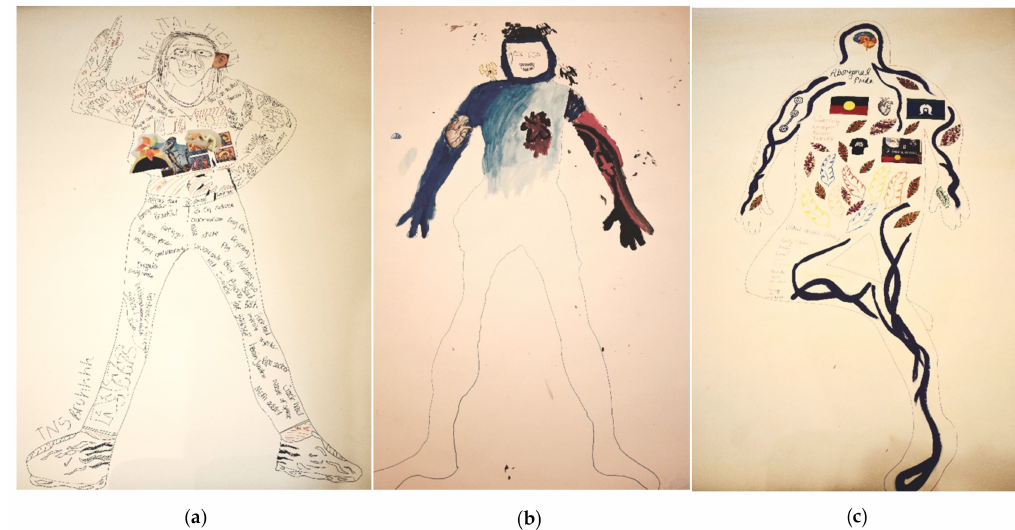
Figure 3. Examples of Body Maps: ( a ) Emma’s Body Map—Emma described how when she initially started her Body Map, she was in a very negative mindset, so she wrote negative words and illustrated her previous drug use on the right side of her body. However, through the Body Mapping process, she was able to start thinking more positively and was able to include more positive words and the family members and friends who have supported her on the other side of her Body Map. ( b ) Liam’s Body Map—Liam expressed how the blue colour included in his Body Map represented his love for swimming, which is an activity he used to enjoy with his family and is hoping to get back into after he graduates from PALM. It was also used to symbolize the increasing inner strength he has gained through PALM and how this is helping him to gradually overcome his vices, which are manifested by his red/black arm. Spirituality also provided Liam with a lot of support and strength and is illustrated by an angel on his ‘strong’ (blue) shoulder. ( c ) Kaylee’s Body Map—Kaylee discussed how Body Mapping helped her open up about the support she receives from her family, who she usually does not talk about much. The leaves she included on her Body Map were used to symbolize her Nan who had been a big part of her life but passed away. Kaylee mentioned that Body Mapping also helped her feel more in touch with her culture and the process prompted her to include her tribes on her map and other cultural references like an Aboriginal dot